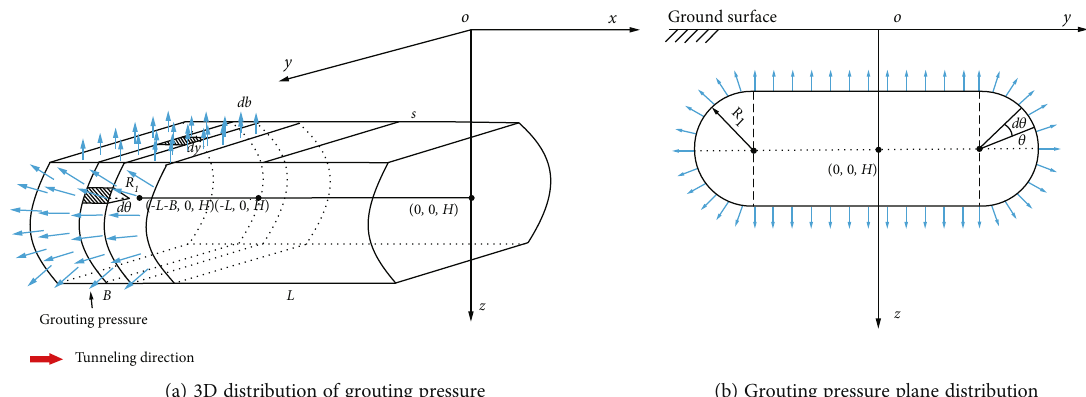
Figure 6: The calculation diagram of additional stress caused by grouting pressure at shield